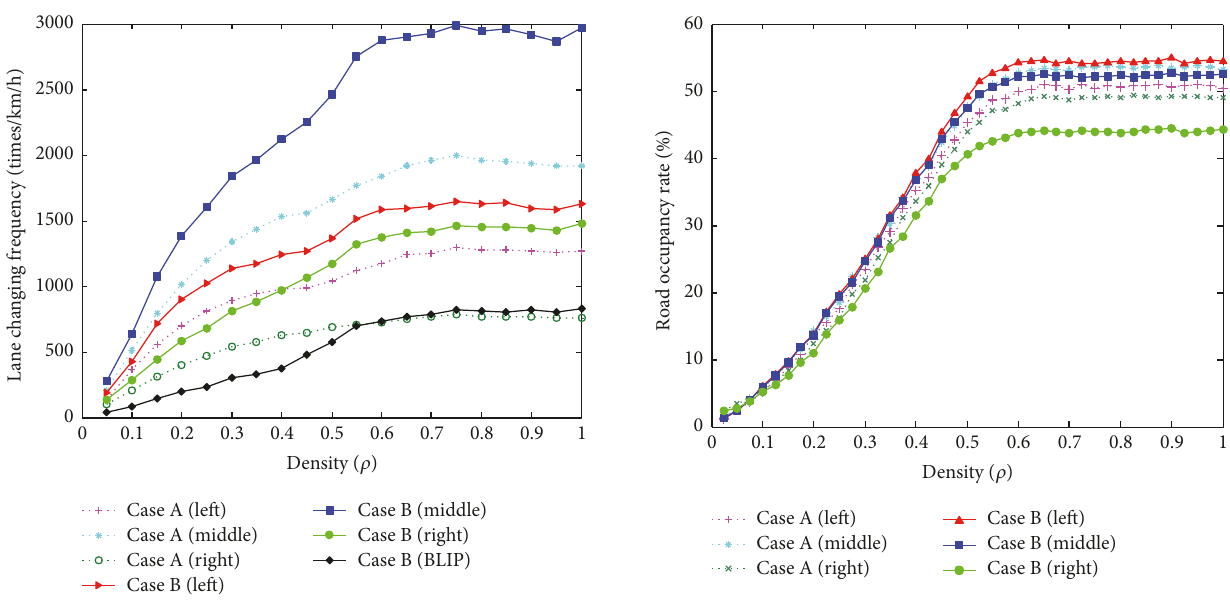
that of the middle lane and both are up to 10% higher than that in the right. Simulation results clearly indicate that cars are now predominantly in the left and the middle lane rather than in the right lane when buses are passing by.